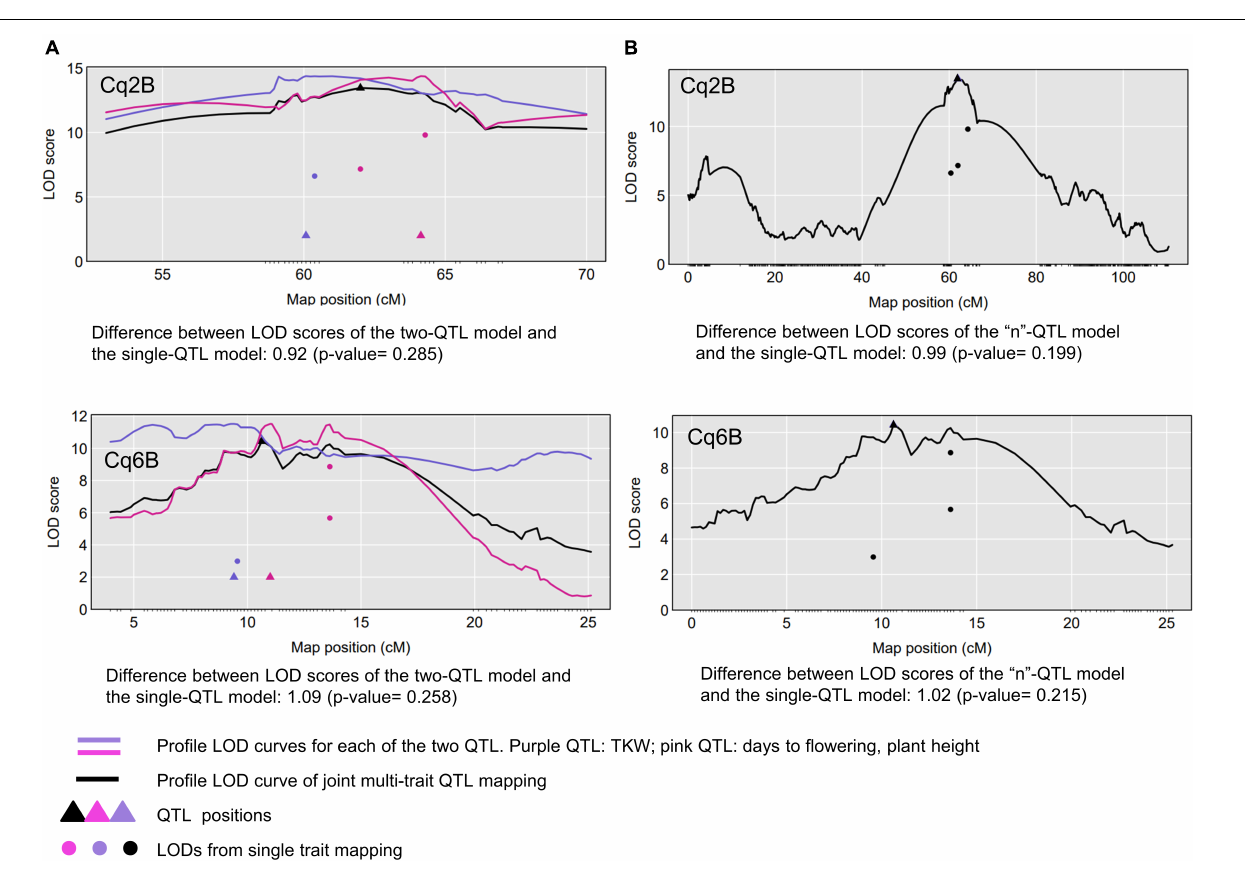
FIGURE 5 | Comparative QTL analysis to detect pleiotropic QTL. Two tests were performed: (A) one vs. two QTL and (B) one vs. “ n ” QTL. Tests were performed considering the traits involved in the QTL found in common for F 2 and F 3 populations (top graphs: pleio4.1 ; bottom graphs: pleio14.1 ). The black curve is the LOD score curve for the single-QTL model, with the estimated QTL location indicated by a black triangle. The blue and pink curves are profile LOD score curves for the for the two-QTL model. Dots indicate the LOD score for the traits considering a single-QTL